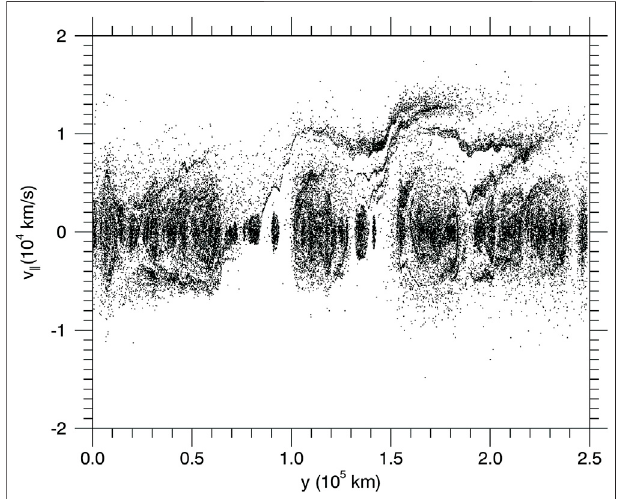
FIGURE 14 | Electron test particle simulations using the sample magnetic fi eld line trace. The distribution in Figure 15 is an ensemble average of many sample fi eld lines taken from the KH active